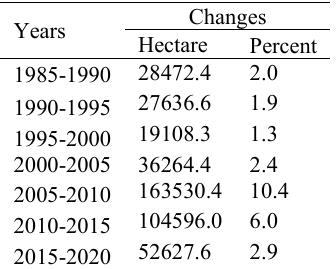
Table 1. Changes in the study area of sandy land of the Ikh Nuuruudyn Khotgor.